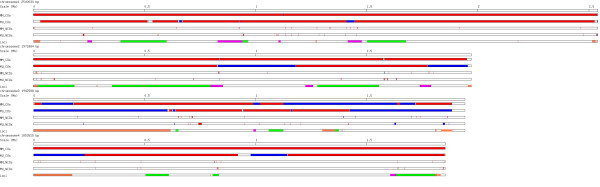
Distribution of crossover (CO) and non-crossover (NCO) recombination events in progeny clones MugugaMarikebuni (MM) and MugugaUganda (MU). Chromosomes 1 to 4 are lined up from top to bottom. The length of each chromosome was scaled to the real genomic size at the ratio of 1 pixel per 1000 nucleotides. In tracks of CO events (labelled as “MM_COs” and “MU_COs”), blue bars represented sequences originated from Muguga, red bars Marikebuni or Uganda. Each colour transition corresponds to a CO breakpoint. Empty regions represent unmapped regions, regions without SNP markers, or regions with such frequent allele changes that their origins could not be clearly defined (such as regions of complex gene conversions). The “NCOs” tracks (labelled as “MM_NCOs” and “MU_NCOs”) show positions of NCO events, with gene conversions to Muguga alleles in blue and to non-Muguga alleles in red. In the track labelled as “Loci”, the known recombination hot spots and cold spots [10] are highlighted as magenta bars and green bars, respectively. Positions of the 27 loci encoding products previously known as immune-relevant [10] are shown as orange bars.